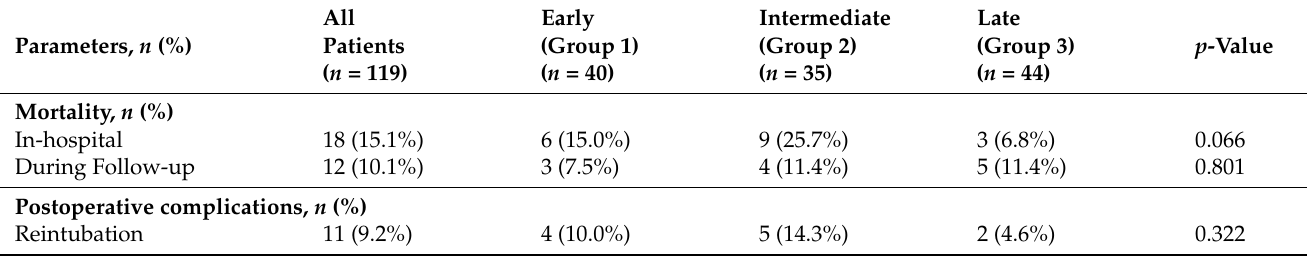
Table 4. Postoperative outcome (n =